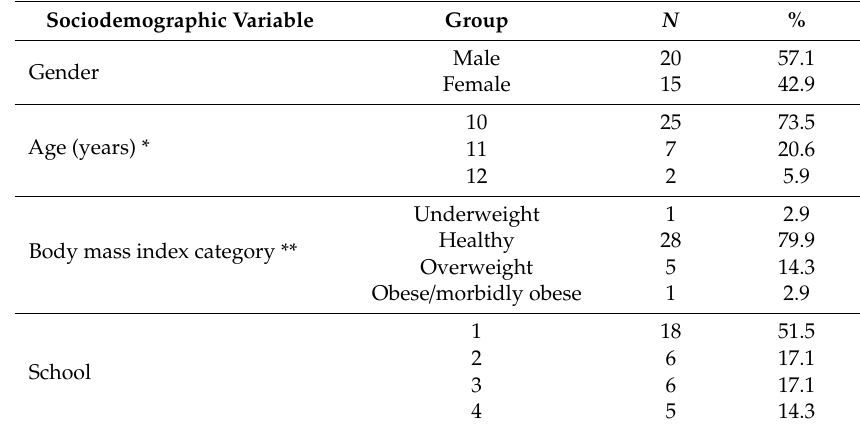
Table 2. Sociodemographic characteristics of participants in Kids’Cam Tonga FOODS study.